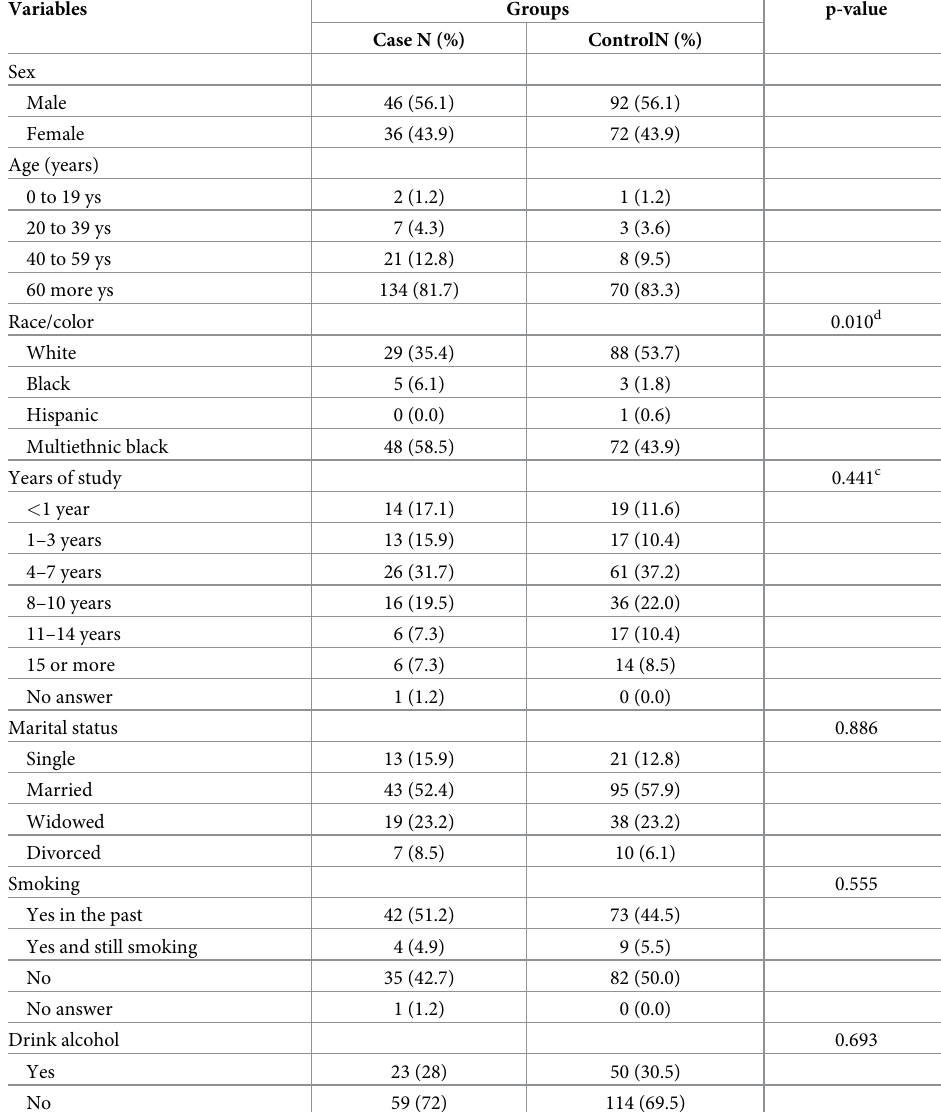
Table 1. Distribution of sociodemographic characteristics of cases (deaths) and controls (survivors). Fortaleza (Brazil), 2017. Variables